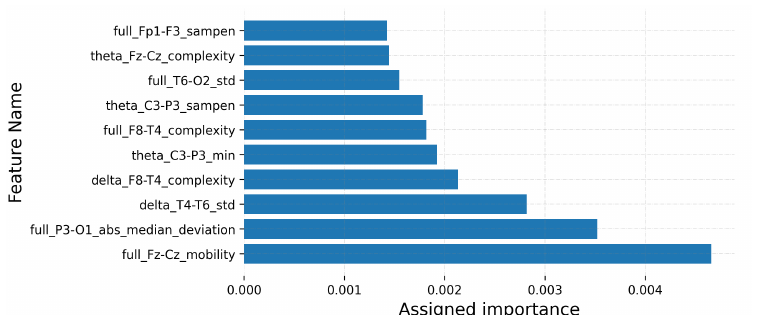
Figure 12. Features having the largest assigned importance. The results correspond to the combina- tion RF-ERF and the Siena dataset. Importance values are not